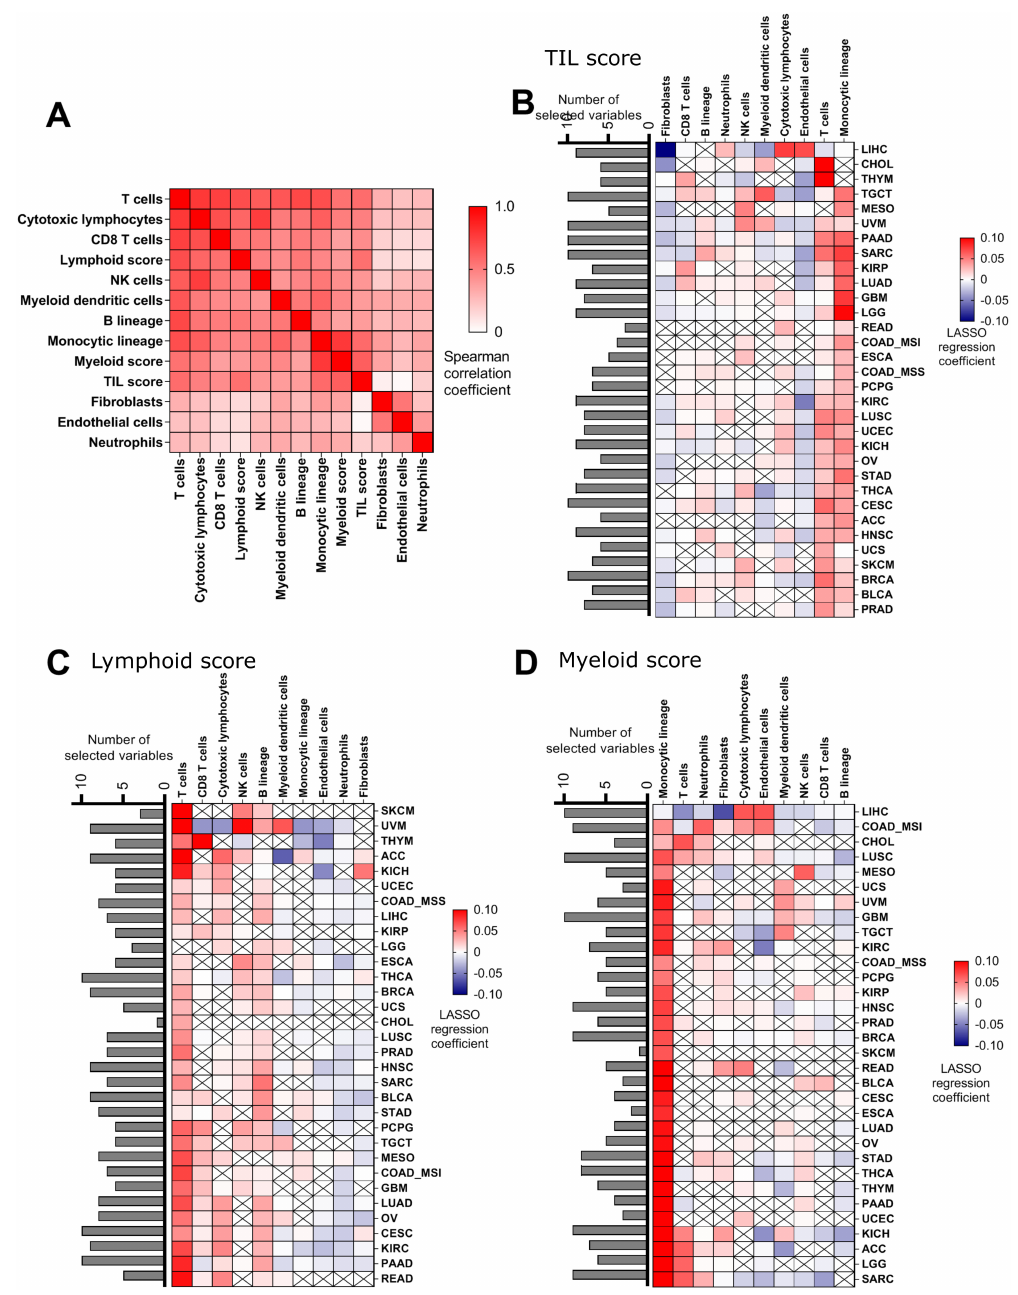
Figure 2. Relation between TIL, lymphoid, and myeloid scores respectively and MCP-counter abundances. ( A ): Spearman correlation matrix estimated for lymphoid, myeloid, and TIL scores as well as absolute abundances of eight immune and two stromal cell populations estimated by MCP-counter. ( B – D ): Heatmaps showing, for each cancer type, the regression coe ffi cients estimated when fitting a LASSO model to describe the relationship between TIL score ( B ), lymphoid score ( C ), and myeloid score ( D ) and 10 cell population abundances. Bar plots in rows represent the number of variables selected in the LASSO